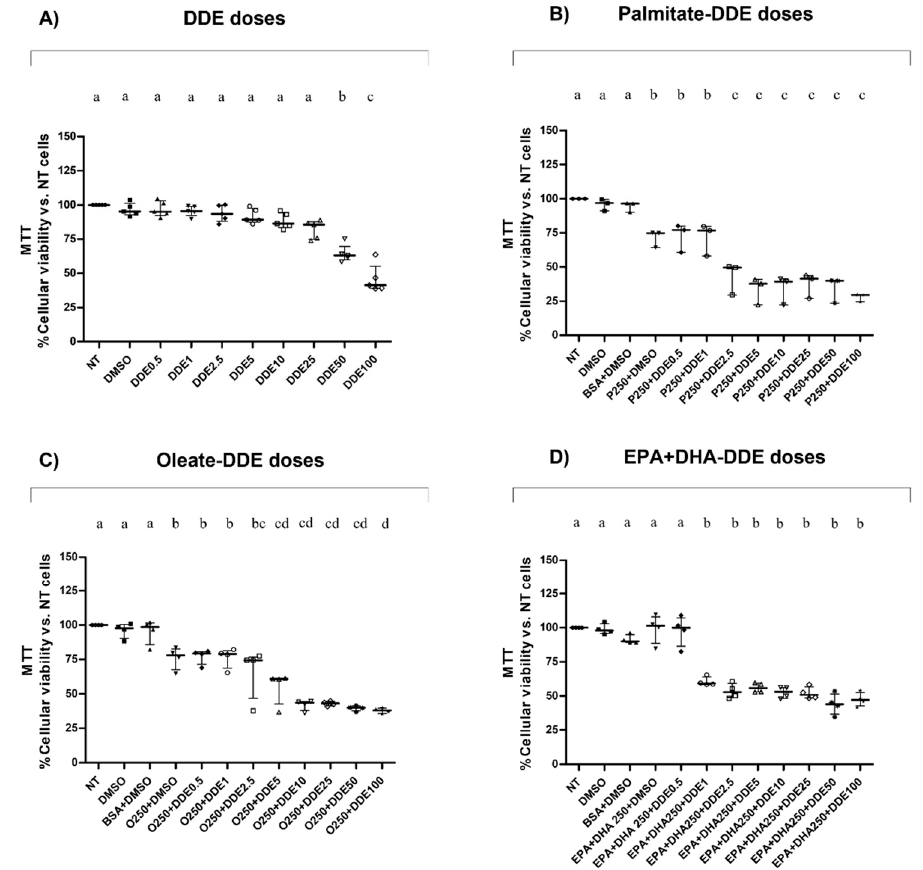
Figure 1. HepG2 cellular viability. Data were obtained stimulating cells with different doses of DDE (0.5 µ M, 1 µ M, 2.5 µ M, 5 µ M, 10 µ M,25 µ M, 50 µ M and 100 µ M) ( A ) or with DDE in association with (0.5 µM, 1 µM, 2.5µM, 5 µM, 10 µM,25 µM, 50 µM and 100 µM) ( A ) or with DDE in association with palmitate (250 µM) ( B ), oleate (250 µM) ( C ), or EPA + DHA (1:1) mixture (250 µM) ( D ). Results were palmitate (250 µ M) ( B ), oleate (250 µ M) ( C ), or EPA + DHA (1:1) mixture (250 µ M) ( D ). Results graphically represented as median with range ( B ) or with interquartile or range ( A , C , D ) for 3 or 4 biological replicates. Statistical analyses were performed using GraphPad Prism software. One-way ANOVA analysis was followed by Bonferroni’s post-hoc test: different letters indicate statistically different values.